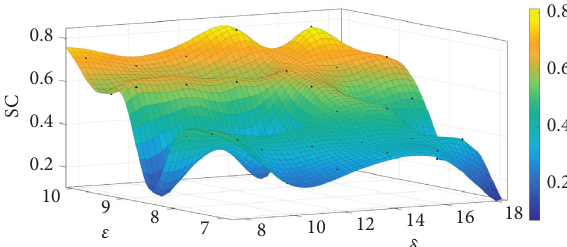
Figure 7: The value of SC corresponding to different